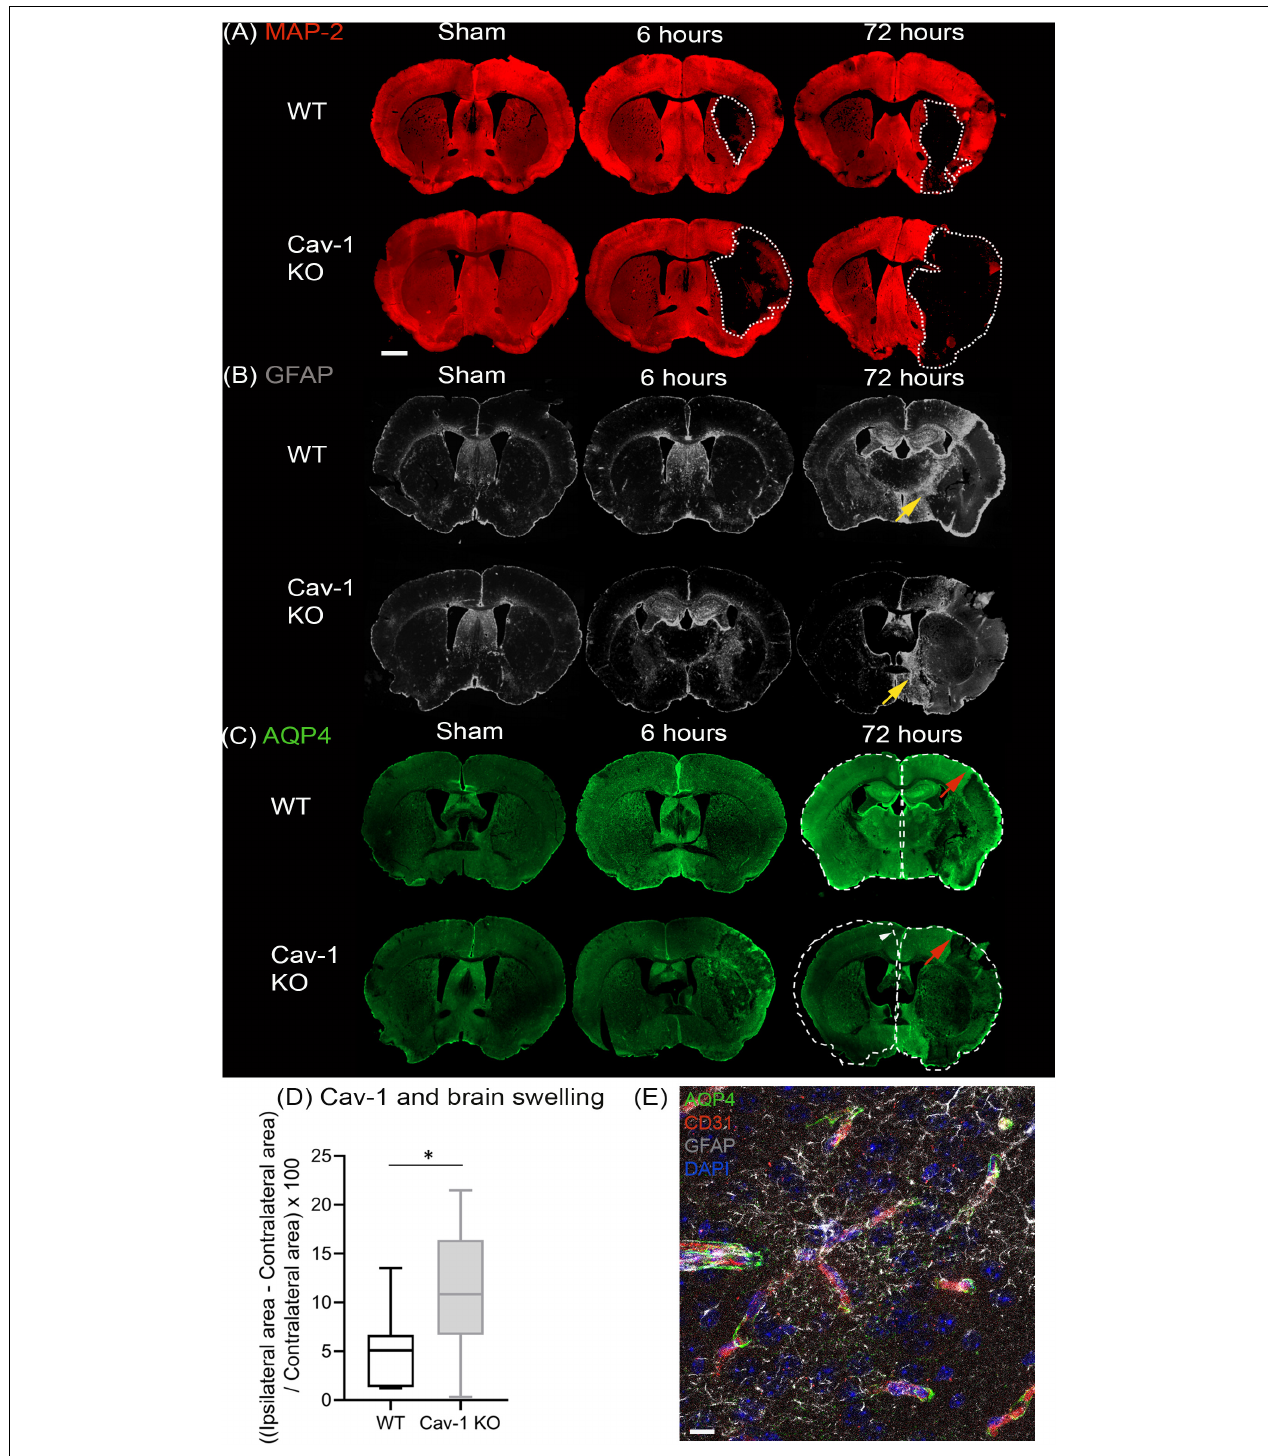
FIGURE 1 | Immunostaining of coronal slices of WT and Cav-1 KO mice after sham surgery and at 6 and 72 h after MCAO: (A) MAP-2 expression (red) showing the lesion outlined by a white dotted line. (B) GFAP expression (gray) showing the extent of the astrocyte scar highlighted by yellow arrows. (C) AQP4 expression (green); the contralateral hemisphere area is delineated by a white dotted line relative to the ipsilateral hemisphere to appreciate the swelling and the white arrowhead points to the shift of the midline due to swelling. Red arrows highlight AQP4 staining in the cortical perilesion. Scale bar = 1 mm. (D) Brain swelling at 7 days after MCAO in WT and Cav-1 KO mice. (E) Immuno-staining at × 63 magnification illustrating the relationship between AQP4 (green), vessels labeled by CD31 (red) and reactive astrocytes (gray), scale bar = 10 µ m.